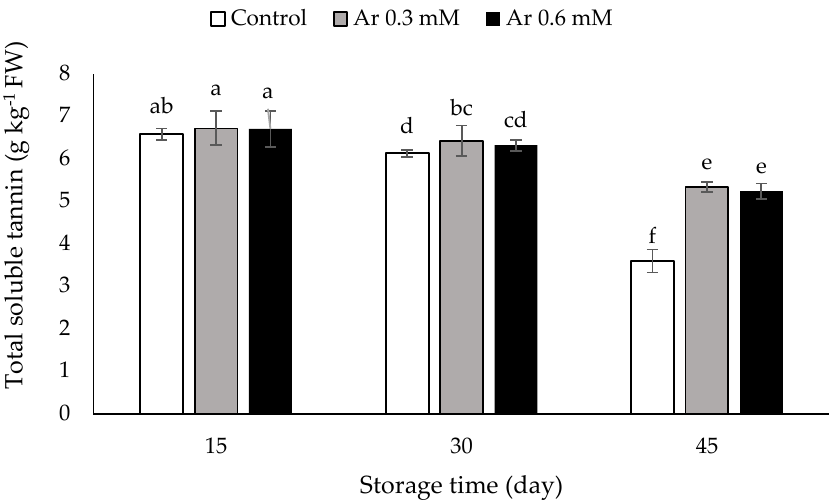
Figure 5. The effect of different levels of postharvest treatment of L-arginine on the total soluble tannins of persimmon cv. “Karaj” fruits during cold storage (DMRT, p ≤ 0.05). The values of data are average of n = 3, and bar represents standard error of the means. Different letters above the bars show significant difference at p < 0.05 by Duncan’s multiple range test.